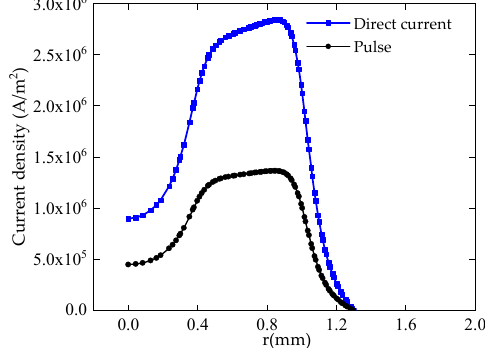
Figure 5. Machining gap current density distribution diagram.